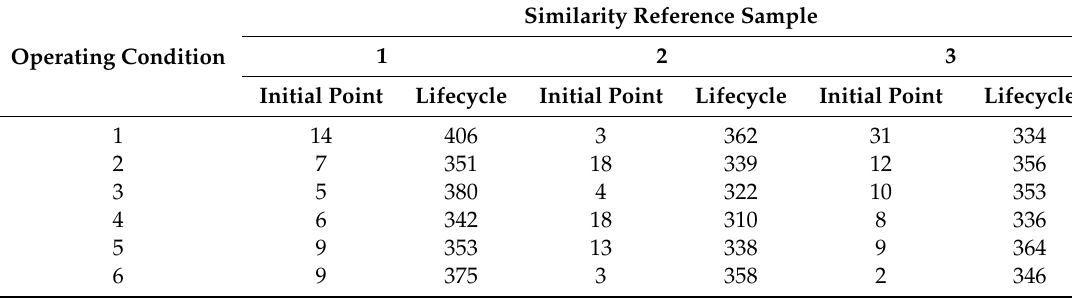
Table 3. The life information of similarity reference